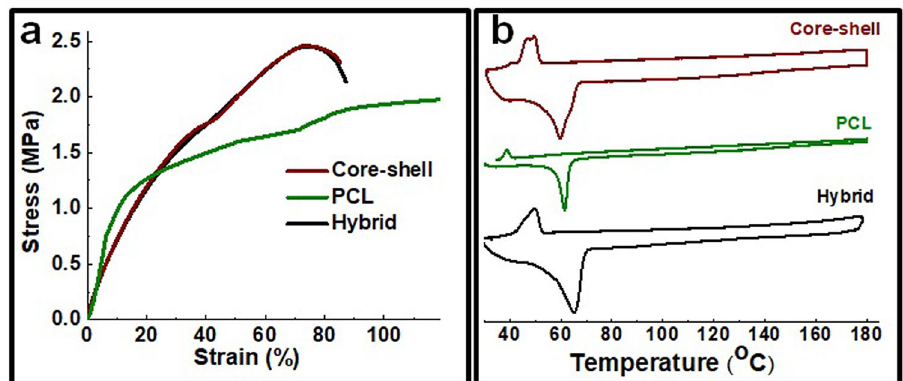
Figure 4. Stress–strain curve (a) and DSC curve (b) of the electrospun scaffolds. The result indicates insignificant effects of PCL encapsulation on thermal transition and mechanical behavior of the CL based hybrid fibrous scaffold.